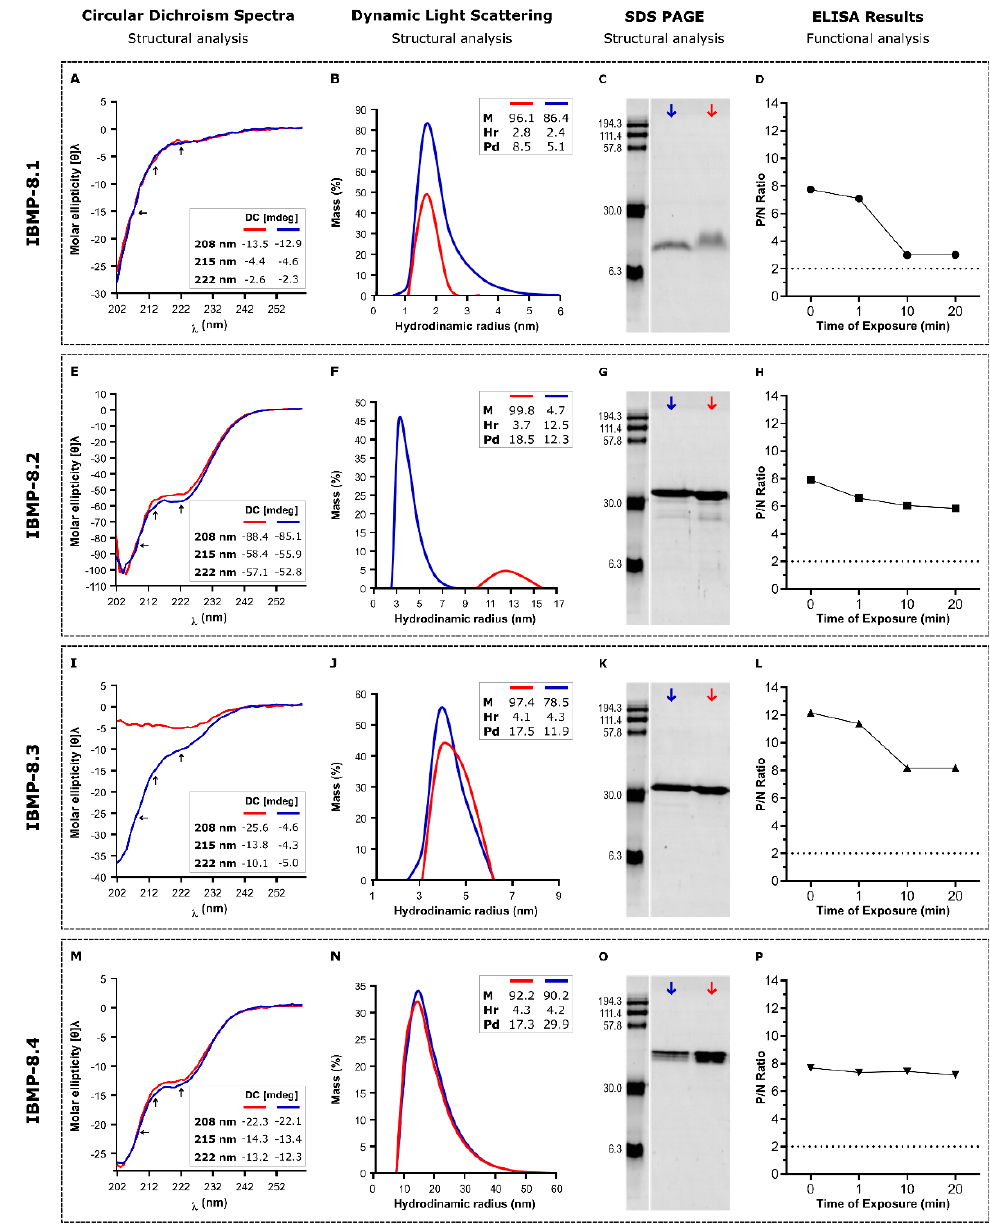
Figure 2. Evaluation of heat-induced denaturation reversibility for the IBMP recombinant chimeric proteins by CD, DLS, SDS-PAGE and sera reactivity by ELISA. CD (Circular dichroism); Hr (Hydrodynamic radius); M (%mass); min (Minute); nm (Nanometer); Pd (Polydispersity); P/N ratio (Positive/negative ratio). Boxes in ( A , E , I , M ) indicate the values of CD signal intensity at 208, 215 and 222 nm. Boxes in ( B , F , J , N ) indicate the values of %mass, hydrodynamic radius and polydispersity. ( C , G , K , O ) are the SDS-PAGE images of the antigens after the treatments. ( D , H , L , P ) shows the reactivity of the antigens in ELISA assay after the heat treatment.